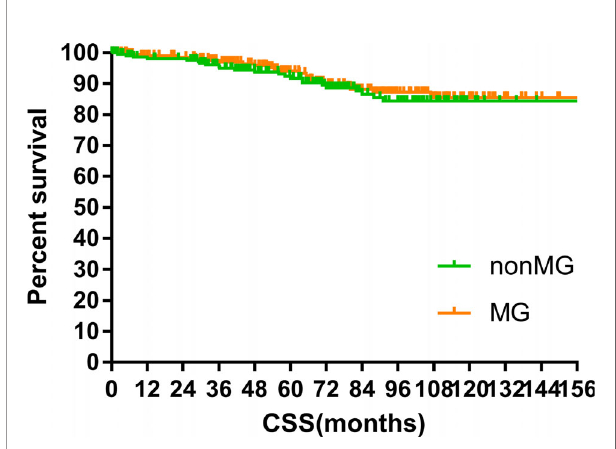
FIGURE 2 | Progression-free survival.